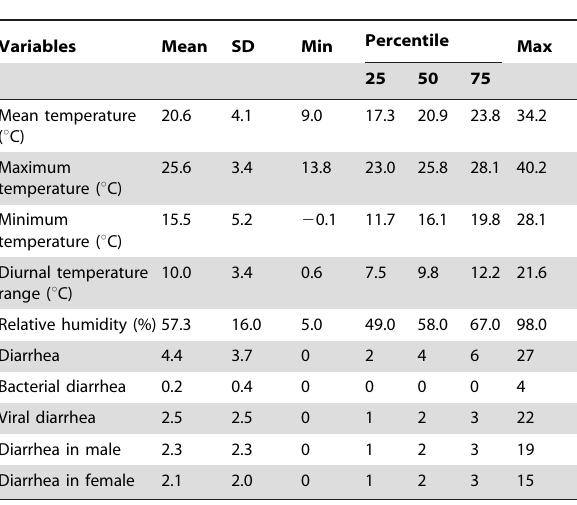
Table 1. Summary statistics for weather variables and diarrhea in children under five years in Brisbane, Australia, from 1 January 2003 to 31 December